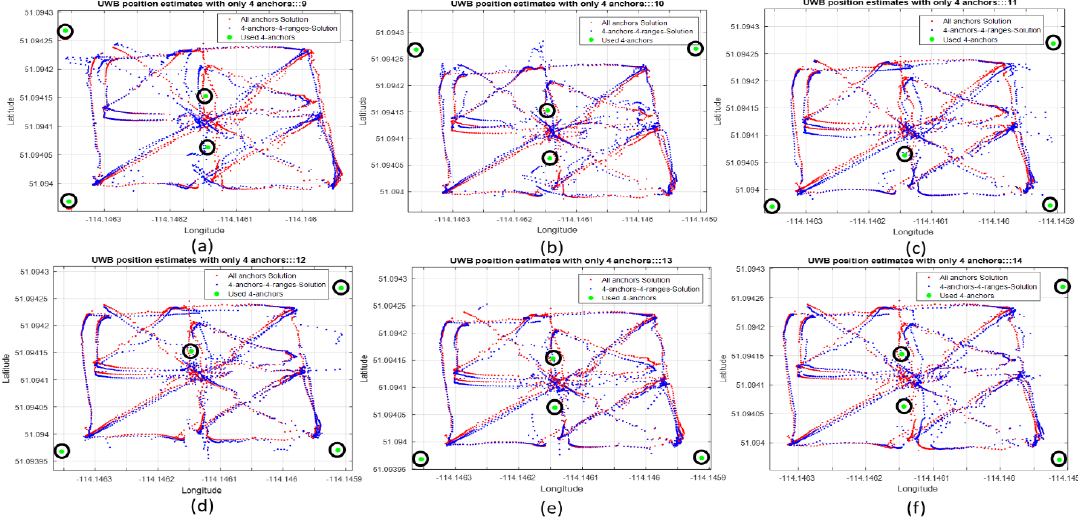
Figure 5. Sample of UWB system positions estimate when utilizing only 4 anchors compared to UWB system when utilizing 6 anchors